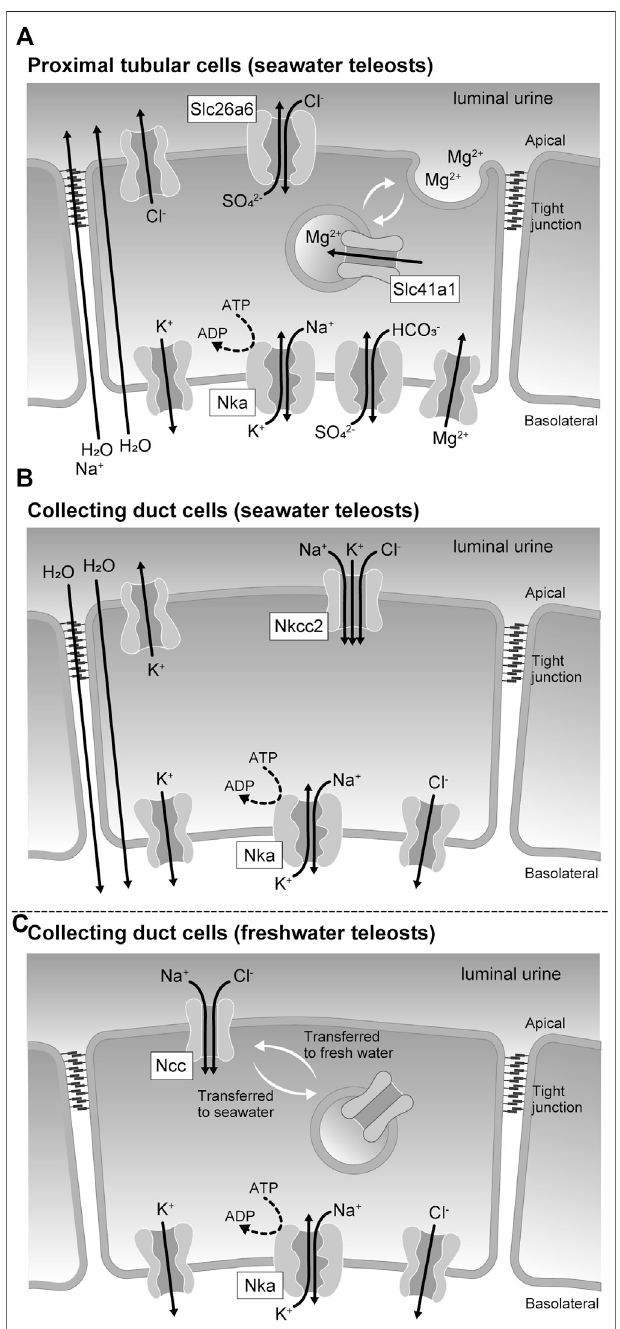
FIGURE 2 | Membrane transport proteins expressed in the renal tubular epithelial cells of seawater and freshwater teleost fi shes. (A) Membrane transporters involved in the sulfate and magnesium ion secretion mechanism by proximal tubular cells of seawater teleosts. (B) Membrane transporters involved in the urinary volume reduction mechanism by the collecting duct cells of seawater teleosts. (C) Membrane transporters responsible for the urine dilution by the collecting duct cells of freshwater